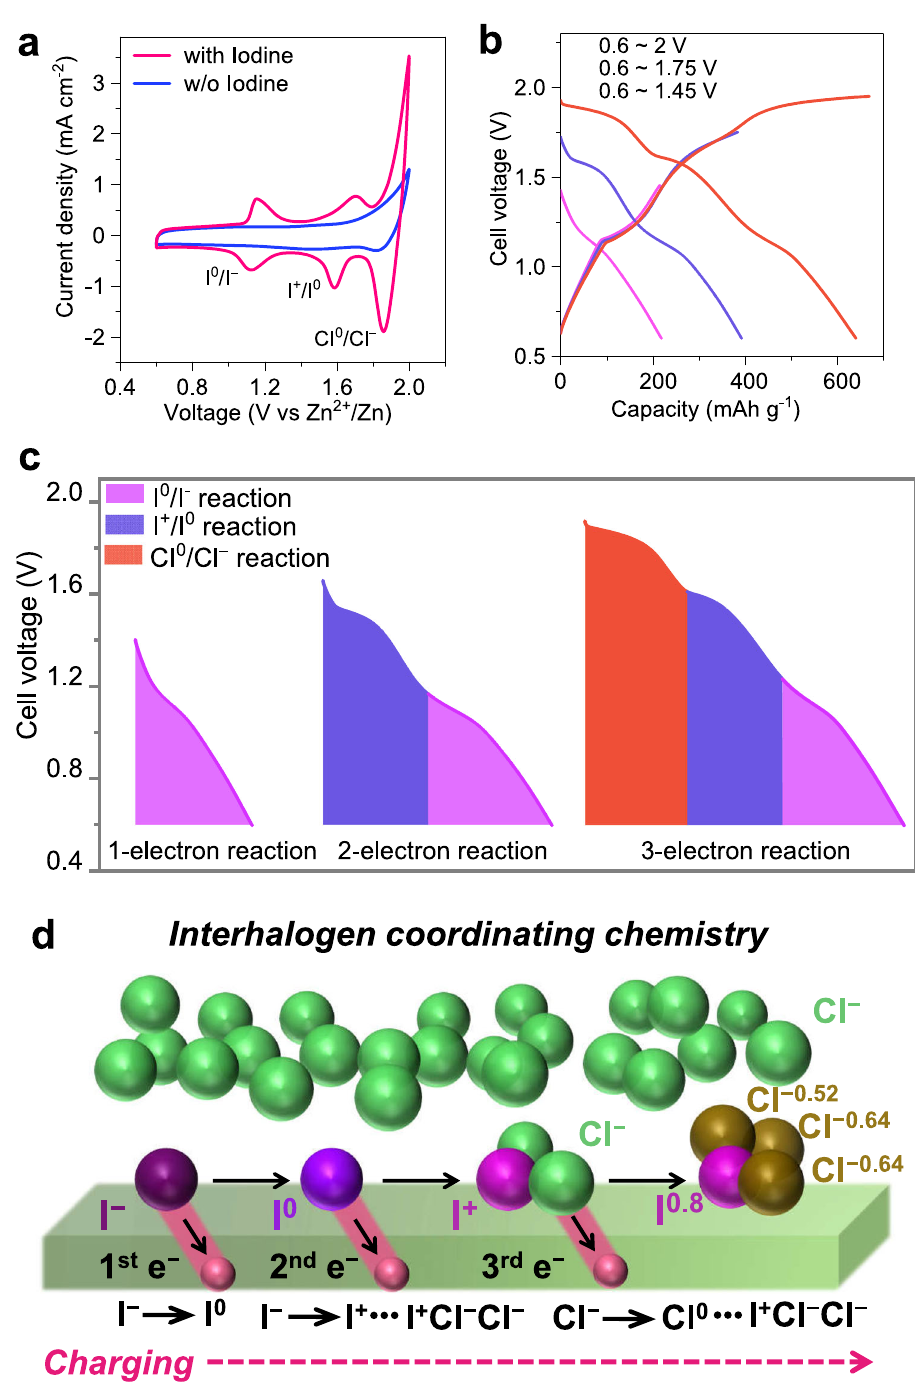
Fig.4|ElectrochemicalinvestigationsonthemultielectrodereactionoftheCl- Ipositiveelectrode.a CVpro fi lesat0.1mVs -1 tostudythetwofunctionalitiesofIin I-containing and I-absent electrodes. b GCD pro fi les of the Cl-I electrode operated within different potential ranges at 0.5A g I2 -1 in a Zn ǁ Cl-I pouch cell at 25°C. c Identi fi cation of the various stages in the electrochemical reaction via cell